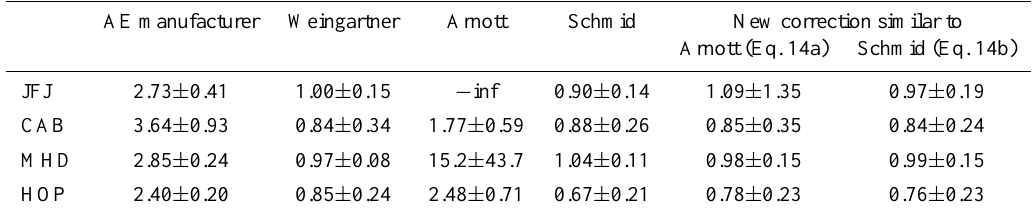
Table 5. Averages and standard deviations of the monthly slopes between MAAP ( λ =630nm) and AE (reported at λ =630nm) absorption coefficients measured at the four stations for manufacturer estimation and each AE